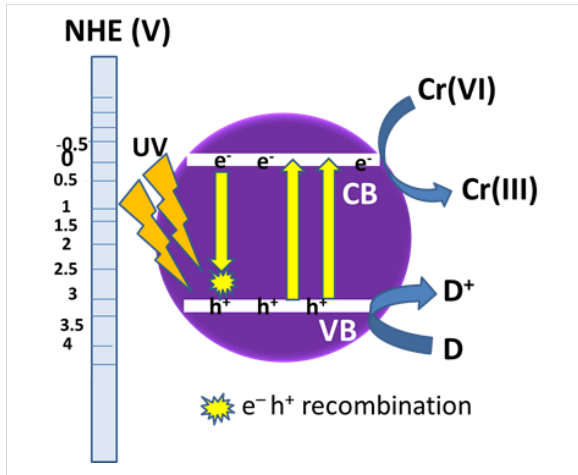
Figure 3: Mechanism of photocatalytic reduction of Cr(VI) over neat TiO 2 . (D = donor, D + = oxidized